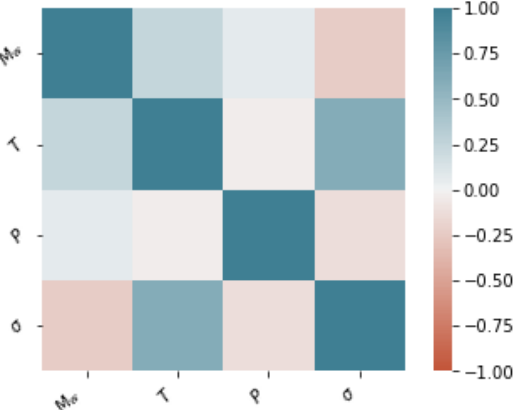
Figure 2. Correlation matrix for the three inputs and the output, σ .